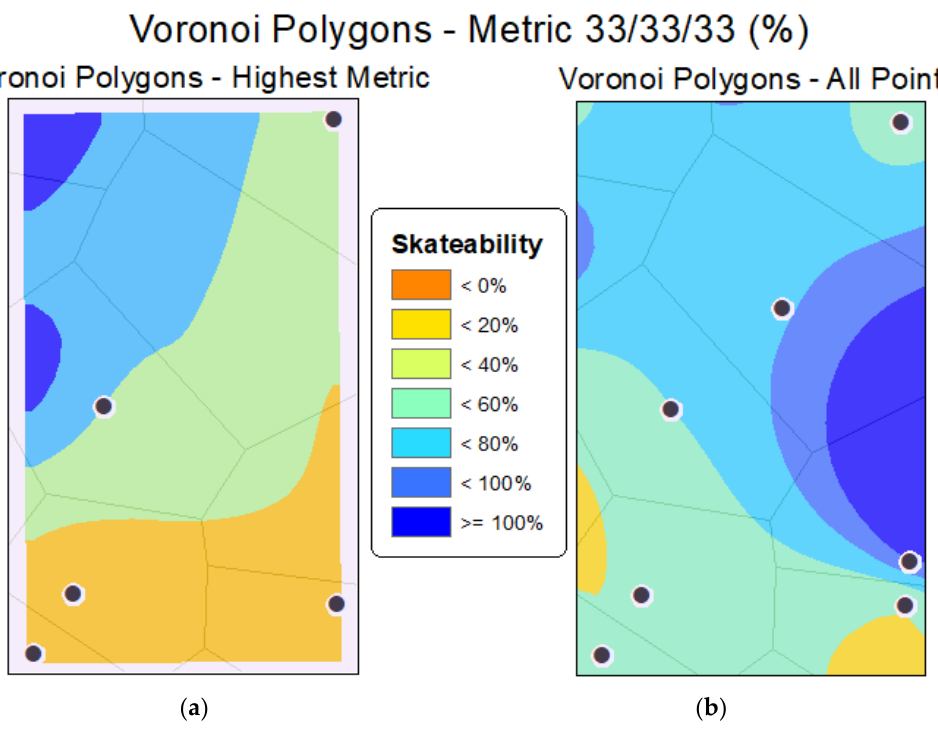
Figure 5. Using Voronoi polygons, a spline interpolation surface fit based on rink skateability. The left surfaces ( a ) are the optimal areas with the right surfaces ( b ) showing the complete study area. Index component weightings are coverage 33%, user-heterogeneity 33%, and density 33%.